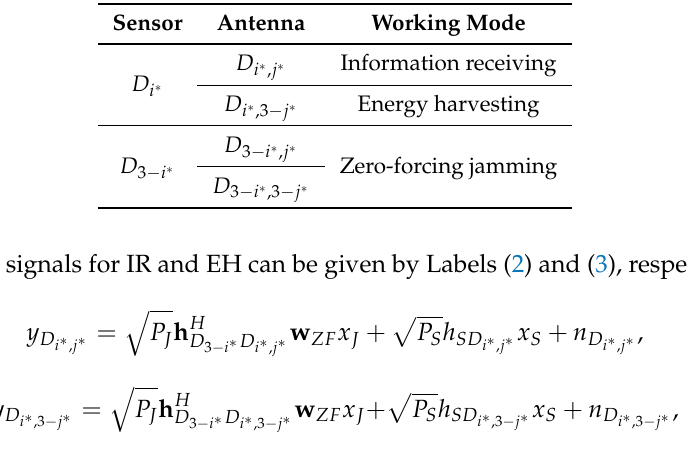
Table 1. Working mode of the sensors and antennas ( i ∗ , j ∗ Sensor